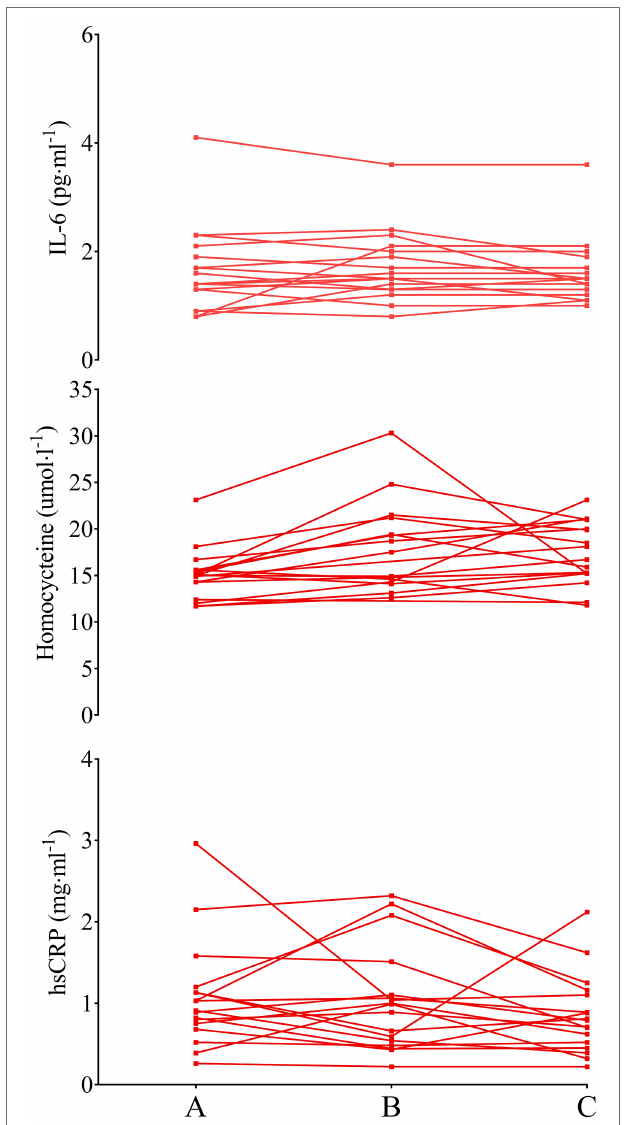
FIGURE 4 | IL-6 (top), homocysteine (middle), and hsCRP (bottom) in LEX older men. Data are presented as individual data points to visualize individual responses. Note, the y-axis for IL-6 and hsCRP has been compressed compared to Figures 2 , 3